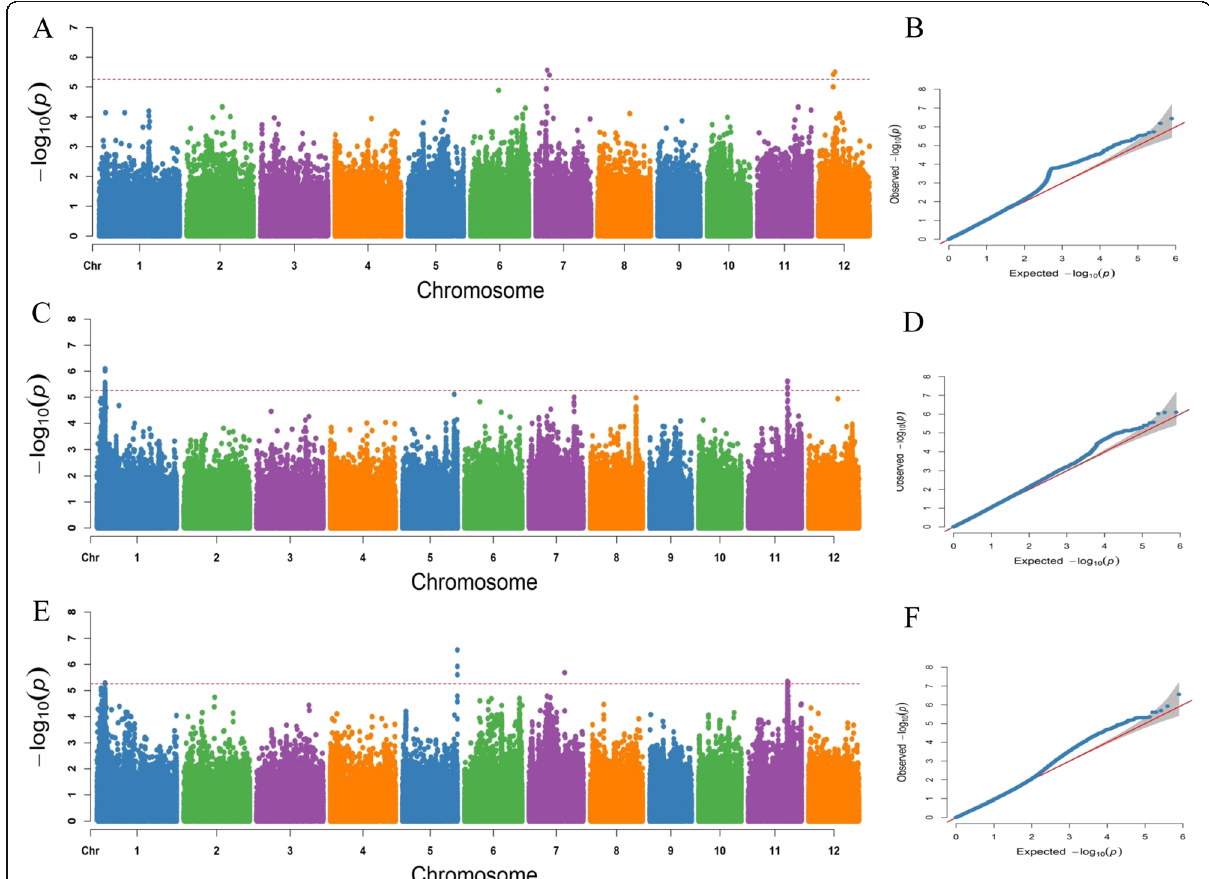
Fig. 2 Manhattan plots and quantile – quantile (Q-Q) plots of GWAS for the RL, ARL and RRL. a , Manhattan plot for the RL. b , Q-Q plot for the RL. c, Manhattan plot for the ARL. d , Q-Q plot for ARL. e , Manhattan plot for the RRL. f , Q-Q plot for